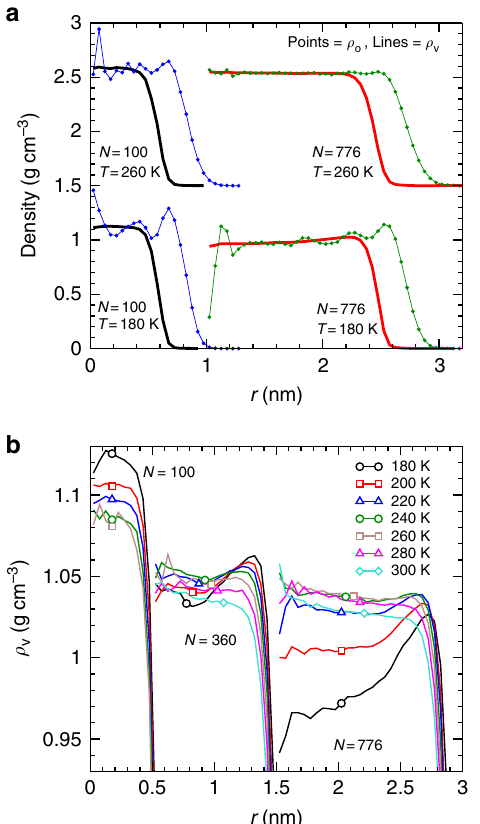
Fig. 4 Nanodroplet density pro fi les. a Density pro fi les ρ o ( r ) (symbols) and ρ r ) (lines) for water nanodroplets at various N and T . For T = 260 K, the v ( curves have been shifted vertically by 1.5 g cm − 3 . For N = 776, the curves have been shifted horizontally by 1 nm. b ρ v ( r ) at various N and T . For N = 360, the curves have been shifted horizontally by 0.5 nm; and for N = 776 by 1.5 nm. In a and b , note that the error increases as r → 0; see Supplementary Figs. 1 and 2.